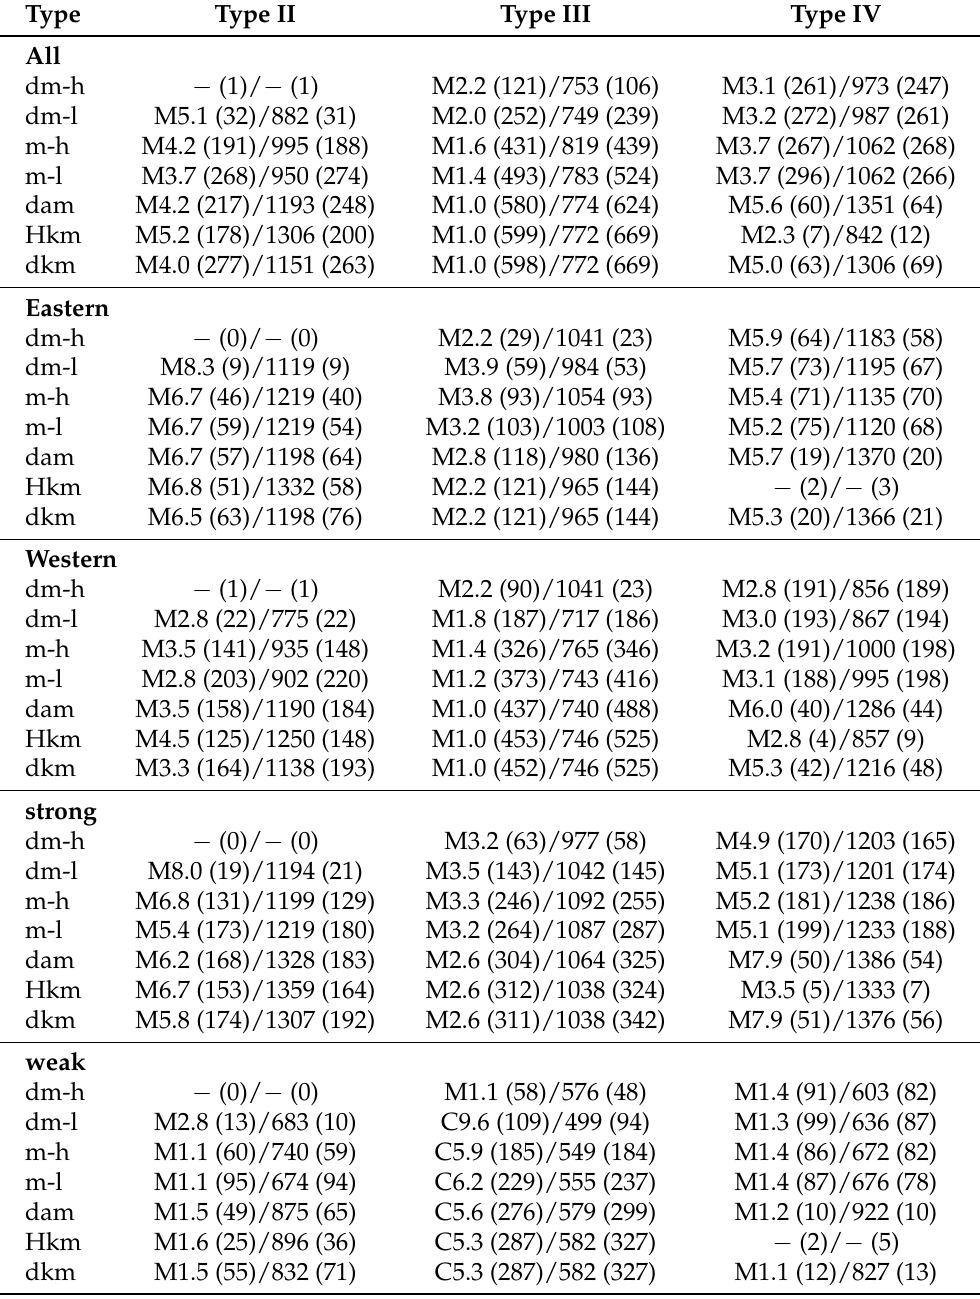
Table 6. Table of the median values of SFs/CMEs for All, Eastern, Western, strong and weak samples. The flare is given in SXR class and the CMEs are given in linear speed (kms − 1 ). The exact size of each sample is given in